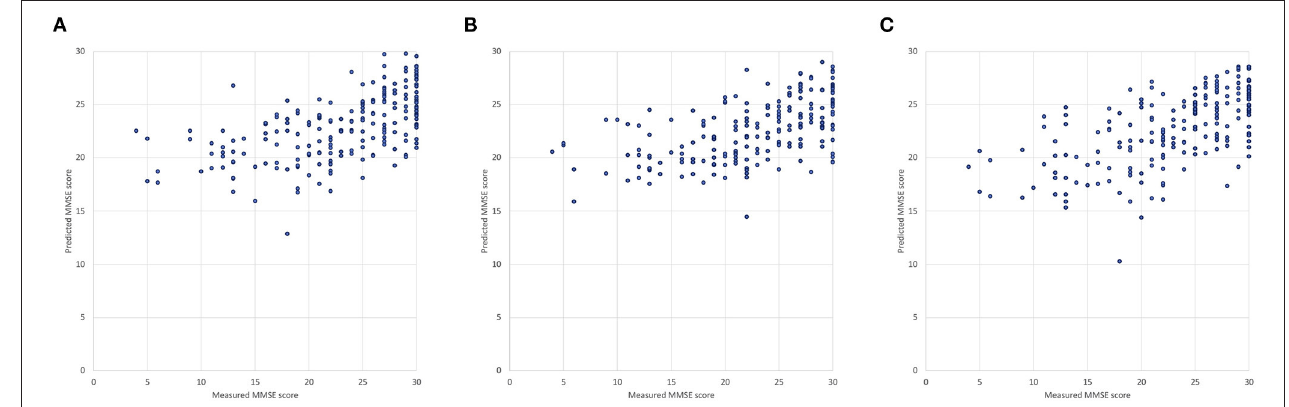
FIGURE 5 | Measured and predicted scores: (A) DNN1 (input variables: age and 23 blood test items), (B) DNN2 (input variables: age and 14 TNIRS parameters) and (C) DNN3 (input variables: age, 14 of the TNIRS parameters and 23 blood test items).